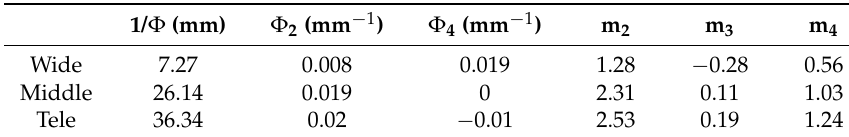
Table 1. Gaussian parameters of the zoom system.